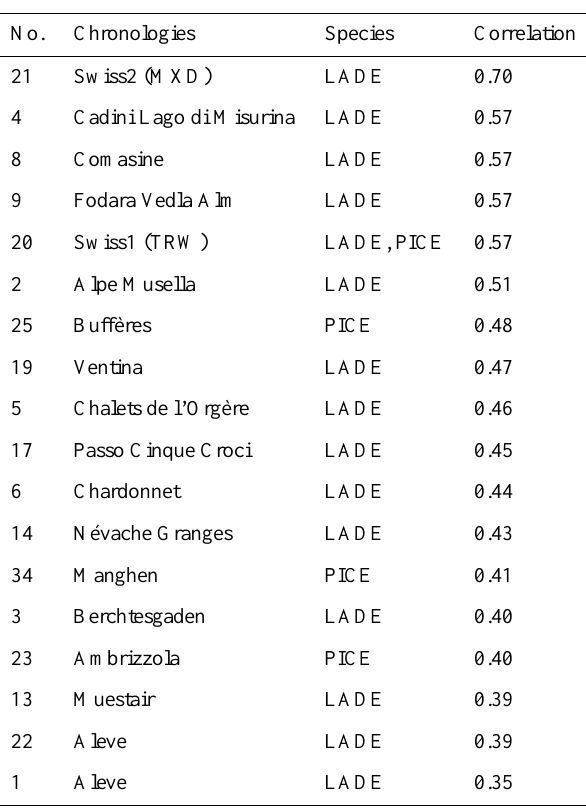
Table 5. Correlation coefficient between the reconstructed tempera- ture of Alps and the proxies used (after estimating the missing data with the analogue method). Coefficients are calculated on the to- tal length of the period analysis, i.e., 1001 observations. Species: LADE: Larix decidua ; PICE: Pinus cembra . The horizontal line indicates significant correlation coefficients (at the 5%